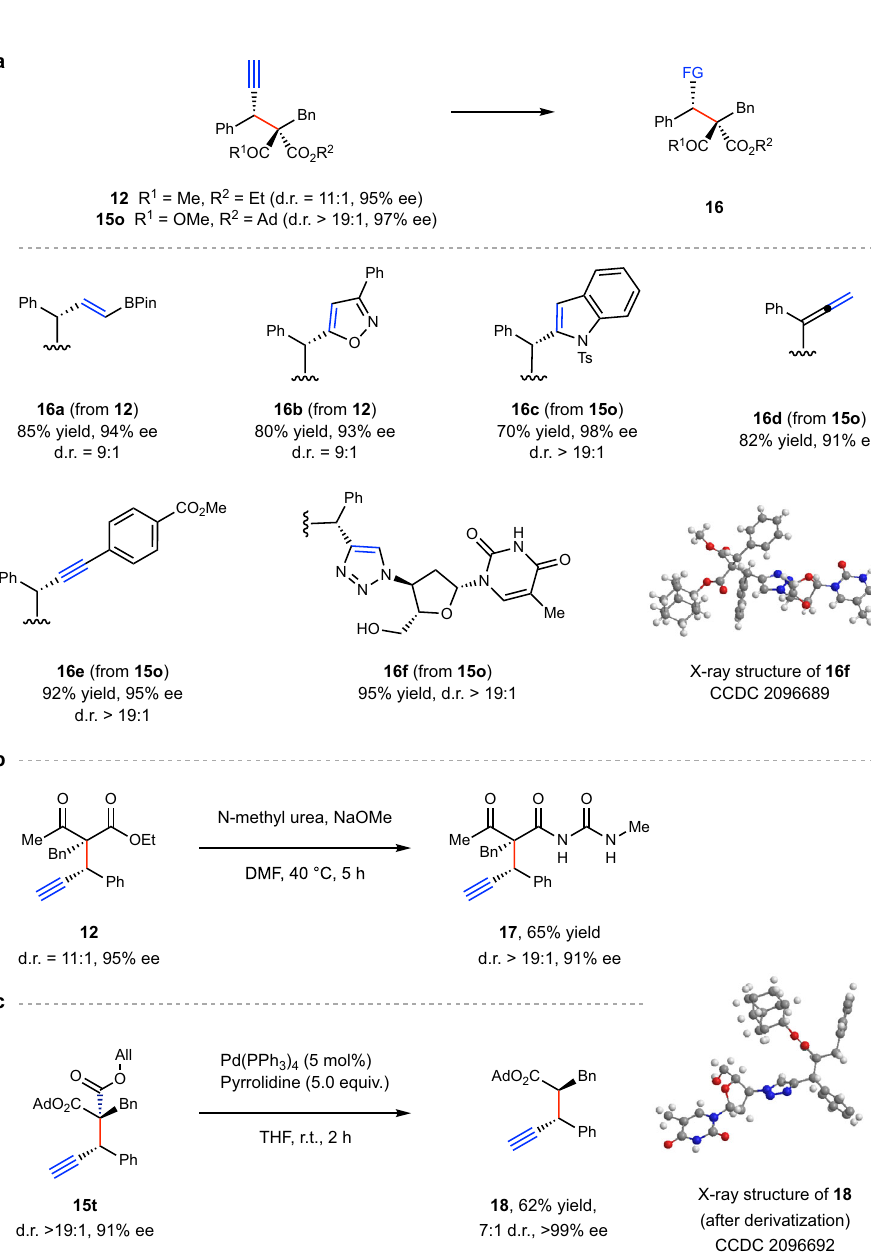
Fig. 5 Product derivatization. a Derivatization of 12 and 15o . b Derivatization of 12 . c Derivatization of 15t . Reactions were performed on a 0.1 mmol scale. Yield is that of an isolated product. The ee values were determined by HPLC analysis. The d.r. values were determined by 1 H NMR analysis of the crude reaction mixture. See SI for experimental